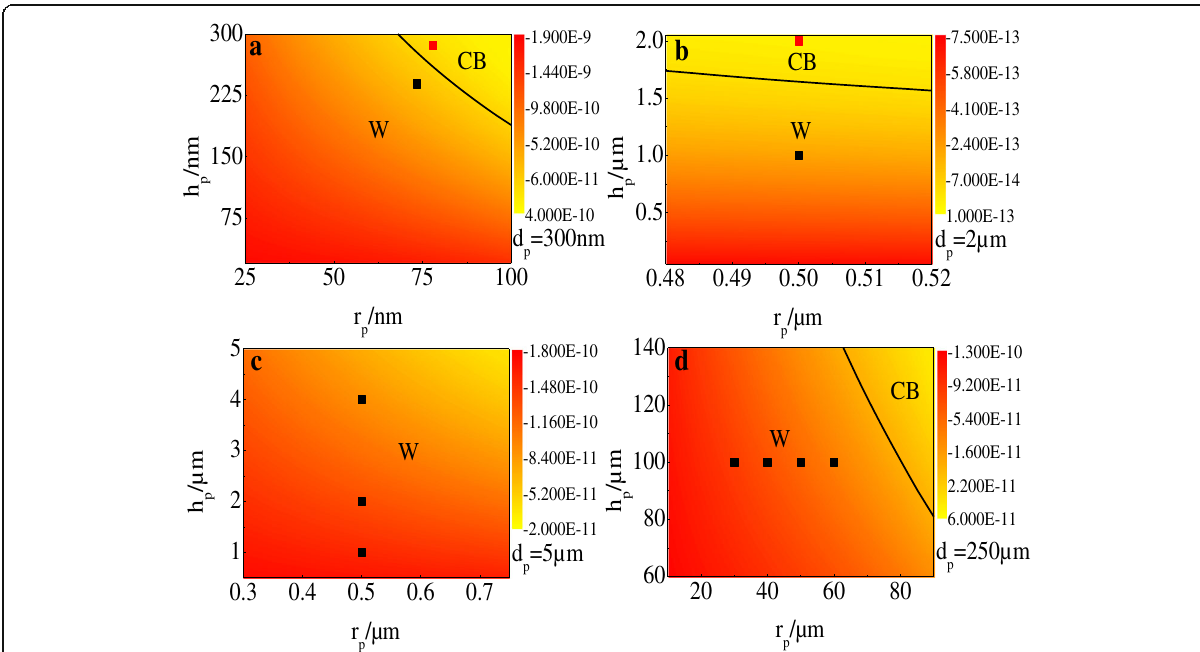
Fig. 5 Phase diagram of wetting states of the water droplet on pillar-patterned surfaces. In each panel , square dots represent experimental results and the black line delineates the W-CB boundary. Pillar spacing d p = 300 nm, experimental results from Ref. 13 ( a ); d p = 2 nm, experimental results from Ref. 38 ( b ); d p = 5 nm, experimental results from Ref. 38 ( c ); d p = 250 nm, experimental results from Ref. 37 ( d